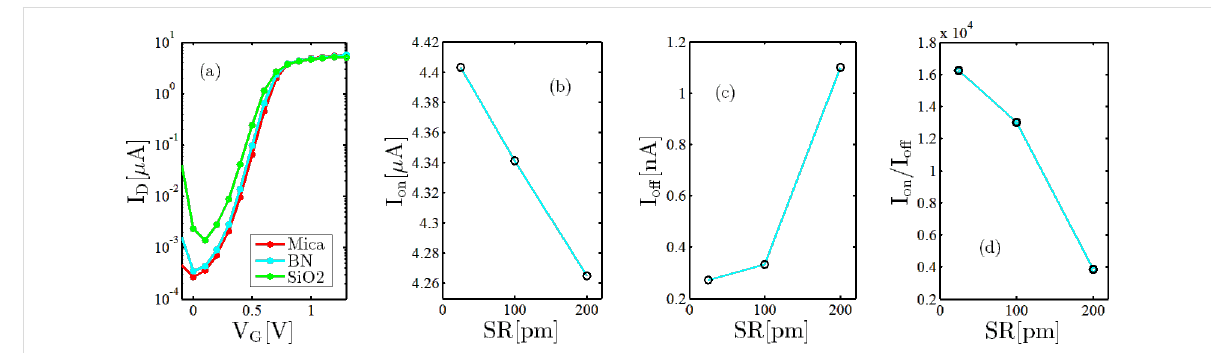
Figure 4: (a) Averaged transfer characteristic (b) on-current (c) off-current and (d) on-/off-current ratio of a 1.56 × 10 nm 2 4h-2BN-ZGNRFET for various substrate materials. In panels (b) to (d) the horizontal axis shows the SR amplitude. The correlation length is considered to be 25 nm for SiO 2 and 5 nm for mica and BN [27,30,31].